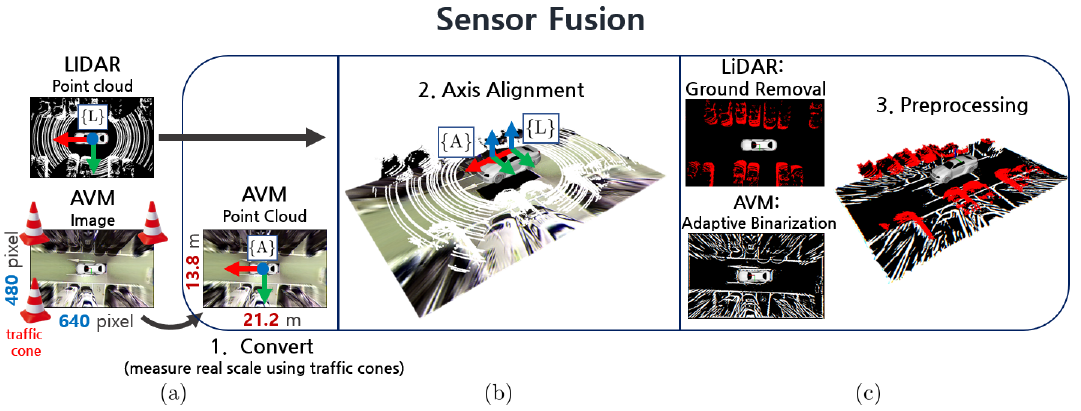
Figure 3. Process of sensor fusion. ( a ) Convert AVM image to point cloud. ( b ) Align axis of both LiDAR and AVM sensor data. ( c ) Preprocessing sensor data to extract a parking line